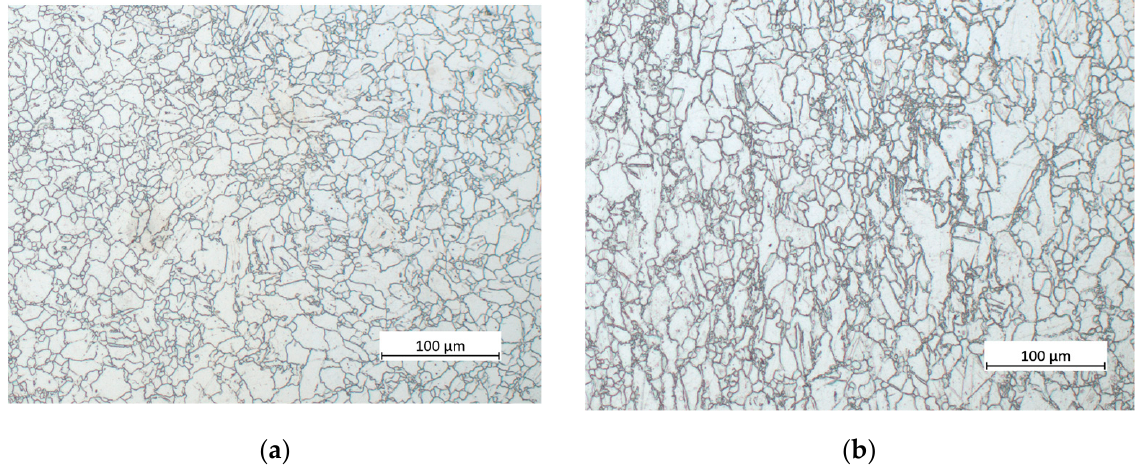
Figure 4. Light micrographs of the sample after quintuple swaging taken from the perpendicular ( a ) and parallel ( b ) to the rotary swaging direction.